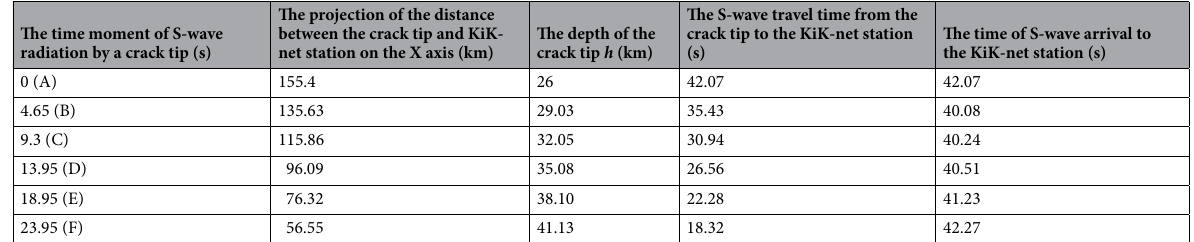
Table 4. Duration of strong motion that was observed at station KSRH10 as a result of crack propagation over a certain part of the fault plane during the Tokachi-oki event ( l ~ 100 km, α ~ 8.7°, V ~ 4.3–4.0 km/s). The duration of strong motion: 2.19